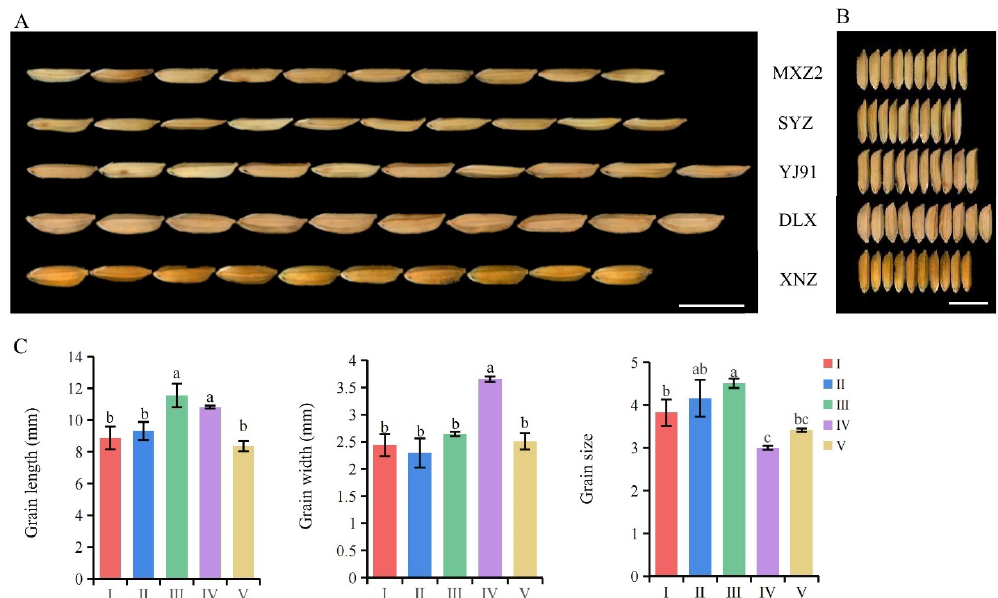
Fig. 3: Grain appearance. A, 10-grain length of five typical Varieties Based on Cluster Analysis; B, 10-grain width of five typical Varieties Based on Cluster Analysis; C, Statistical analysis of grain length, grain width, and grain size (length/width) Based on Cluster Analysis, Bar=10